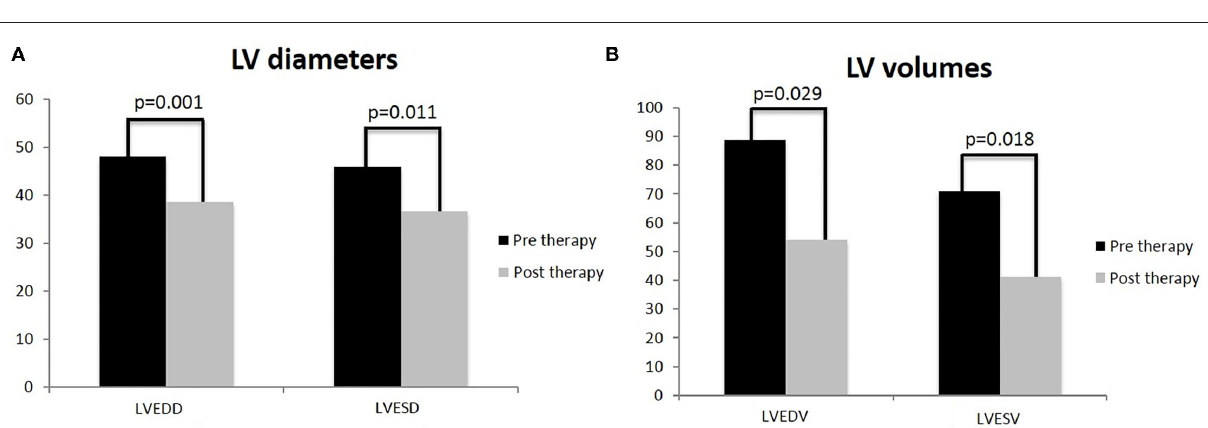
FIGURE 2 | T-test analysis between carvedilol and control group on heart rate (A) and left ventricular ejection fraction (B) at baseline and at 1 year of follow-up.